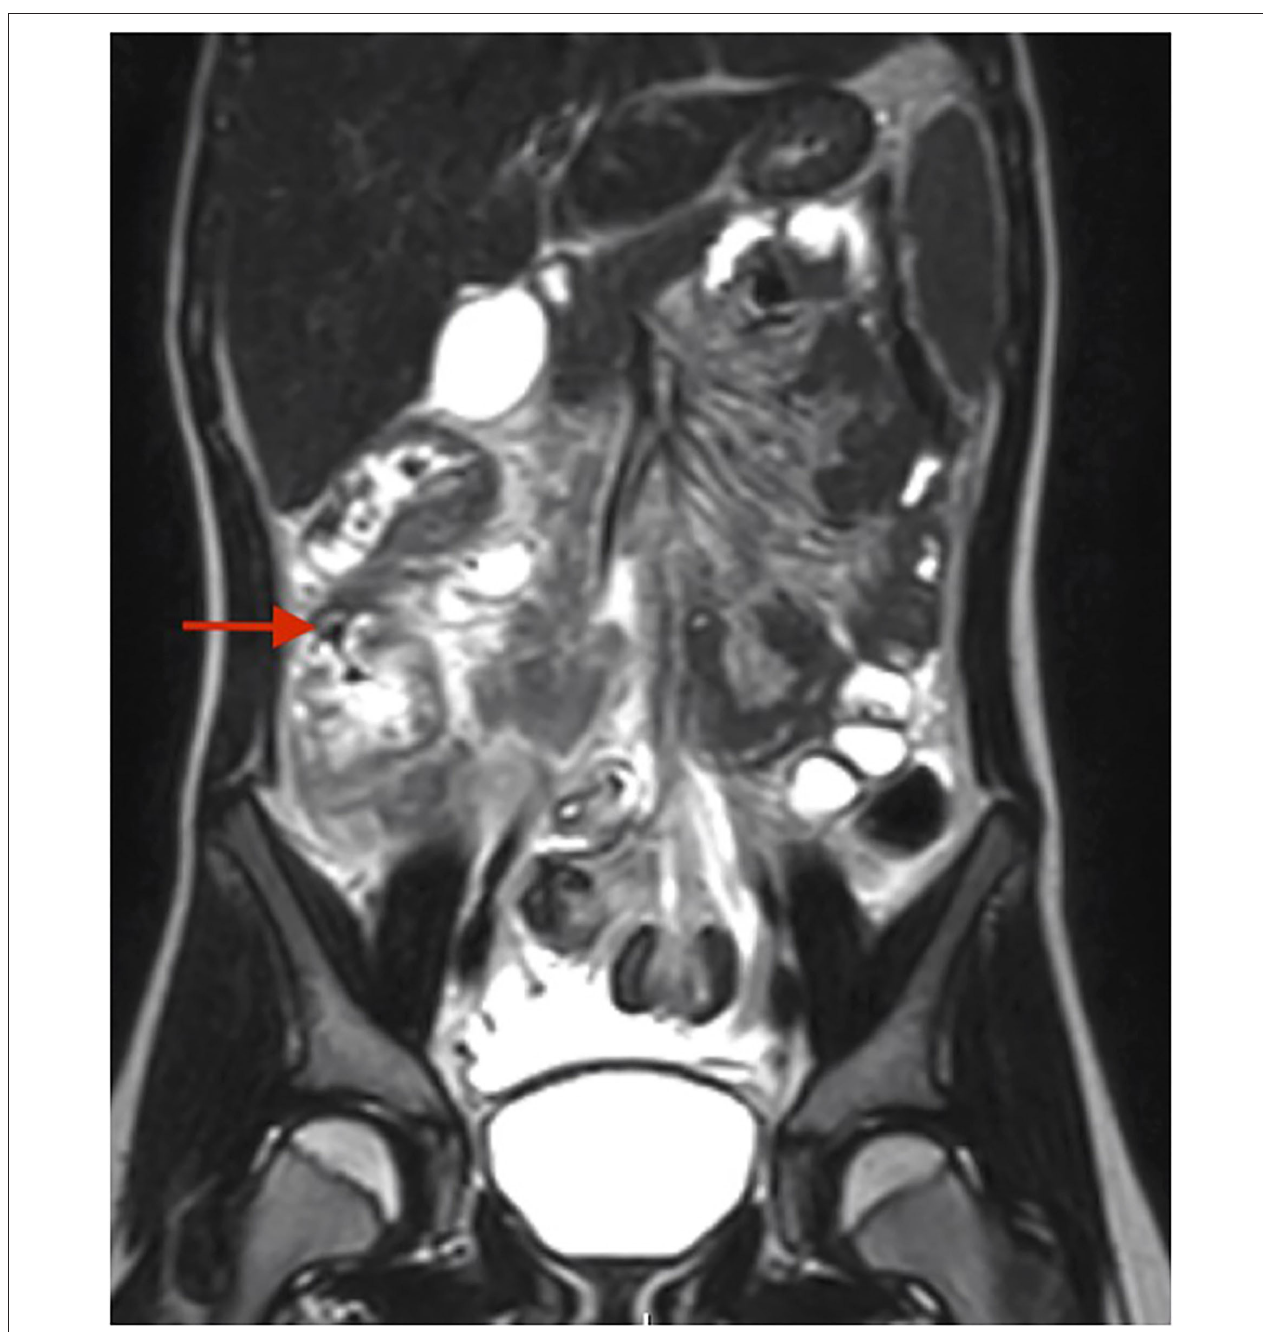
FIGURE 2 | MR enterography for case #2. Red arrow depicts the mural edema and circumferential thickening of the cecum and ascending colon.